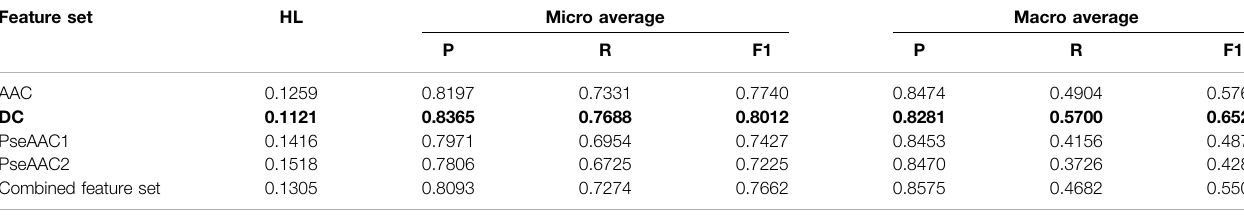
TABLE 4 | Training performance outcome for BR-RF-AdaBoost classi fi er (Note that the best performing feature set is shown in bold). Feature set HL